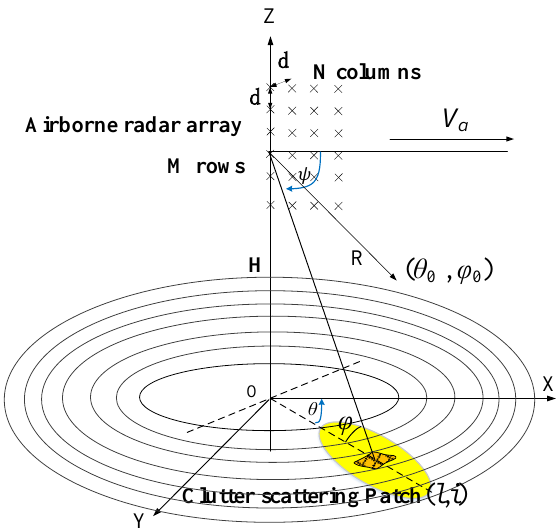
Figure 1. Spatial geometry relation of the airborne multi-channel radar antenna